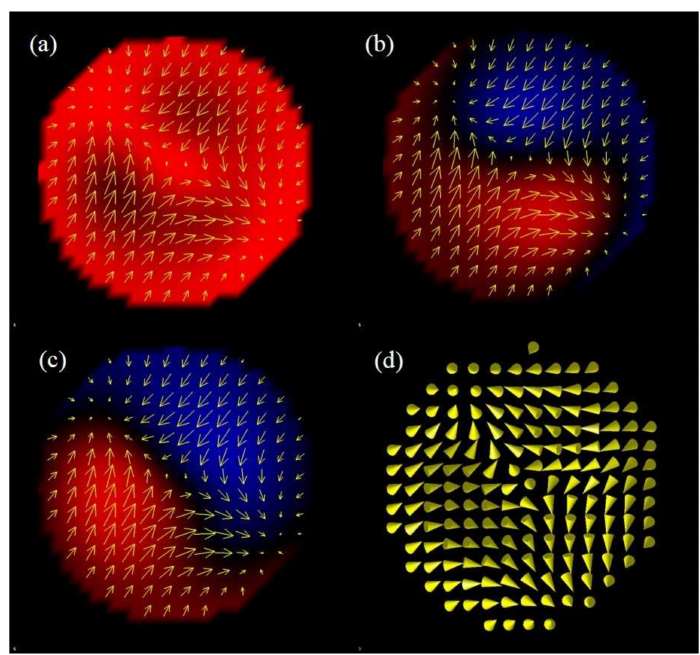
Figure 9. Models of polarization pattern evolution with time after the field E is applied. Arrows ( a – c ) and cones ( d ) denote direction of polarization P. Note that unlike the case in ( a – c ), it is obvious that P is not confined to the plane in ( d ). These simulations were done [38] by H. J. Fan in 2008, perhaps ahead of their time; most interest in spatial spiral patterns developed almost a decade later [39].